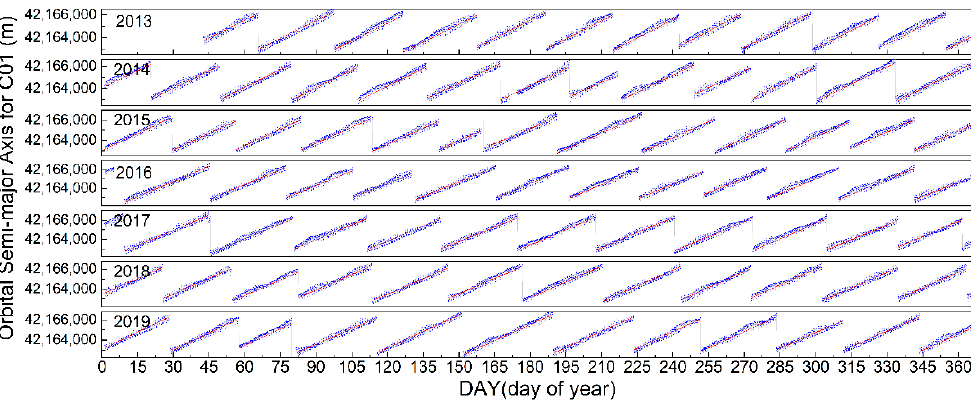
Figure 4. Time series values of orbital semimajor axis for C01 from 11 February 2013 to 12 December 2019.